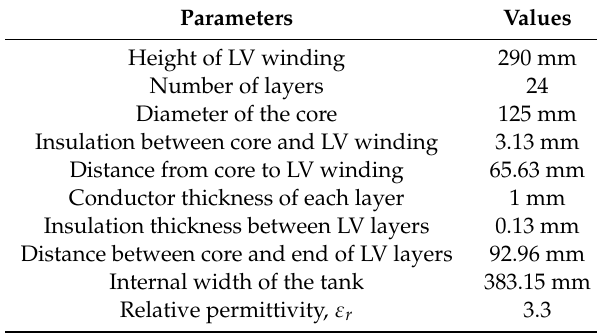
Table 4. LV winding geometry